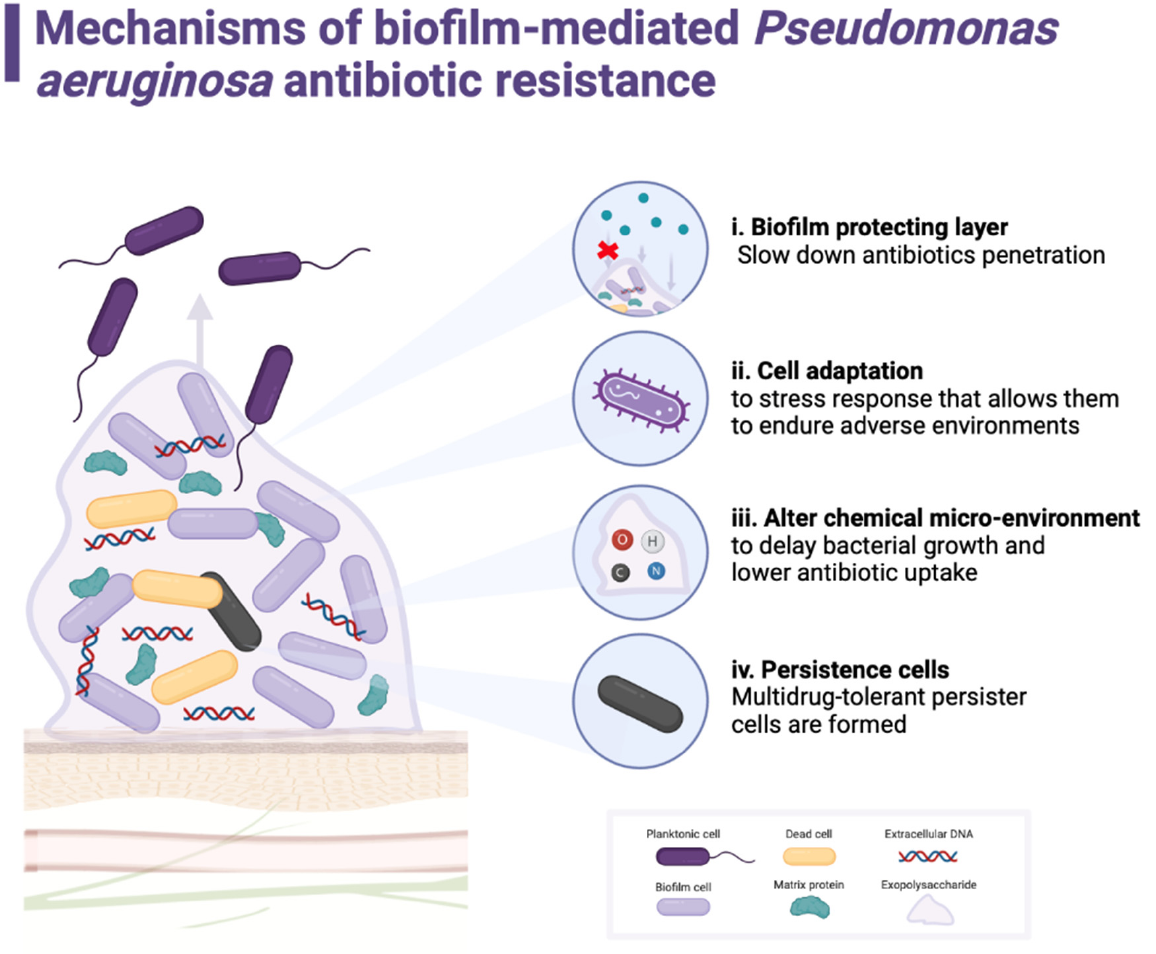
Figure 1. Mechanisms of P. aeruginosa biofilm-mediated antibiotic resistance.